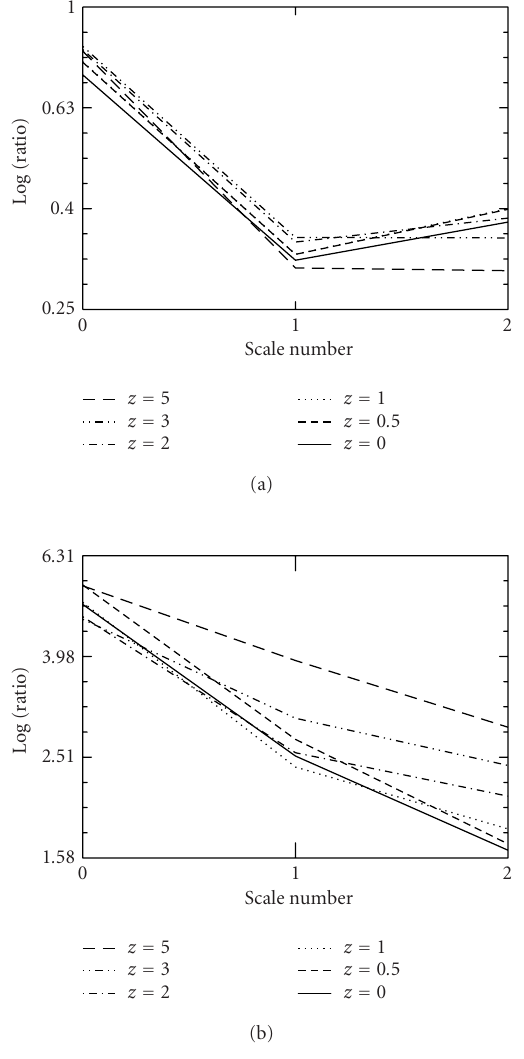
Figure 16: (a) Wavelet/beamlet M w/b ( z , j ) and (b) wavelet/ridgelet M z , j ) curves for the scale number j equal to 1,2, and 3. w/r (